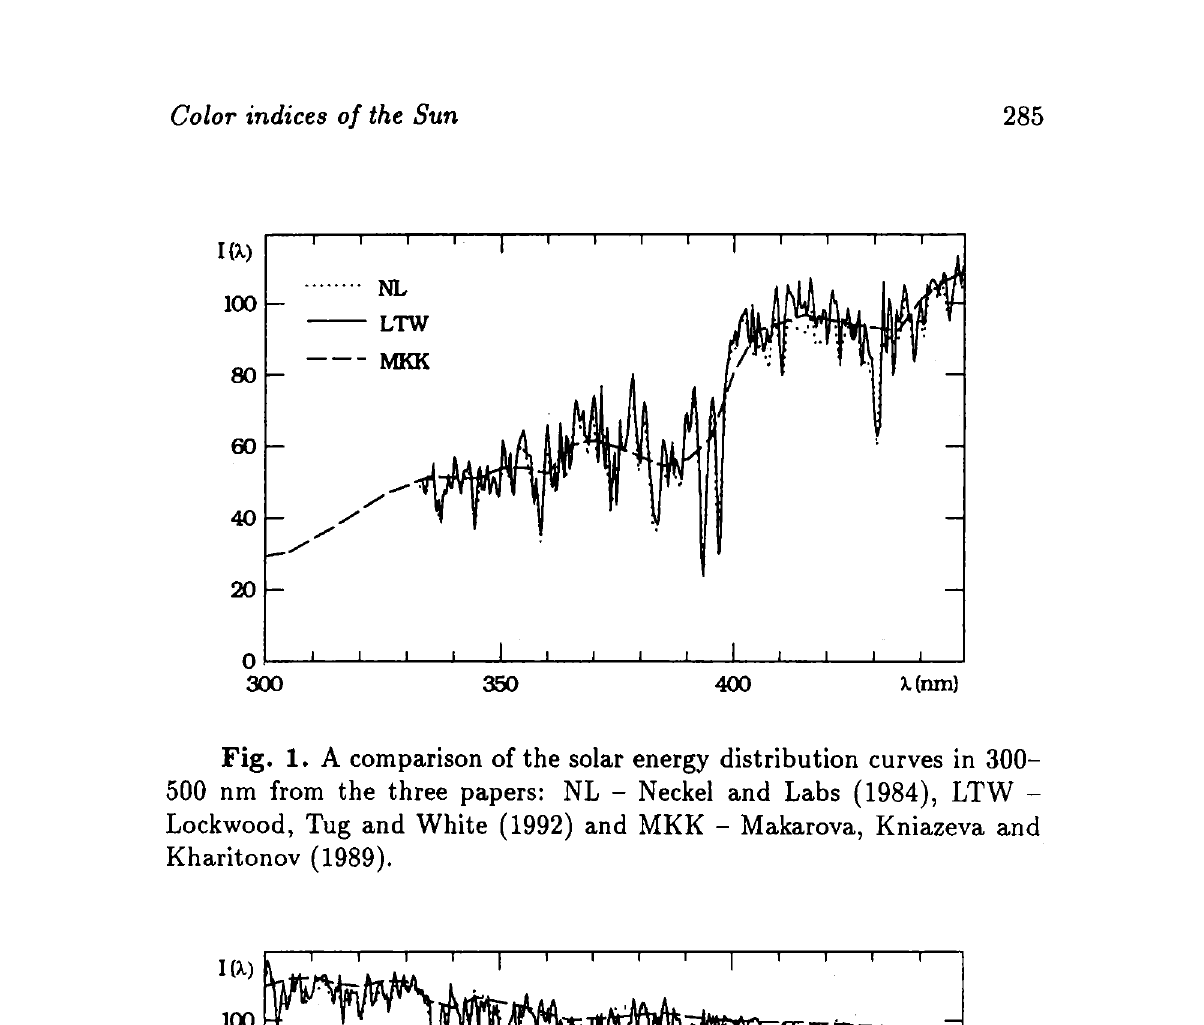
Fig. 1. A comparison of the solar energy distribution curves in 300- 500 nm from the three papers: NL - Neckel and Labs (1984), LTW - Lockwood, Tug and White (1992) and MKK - Makarova, Kniazeva and Kharitonov (1989).